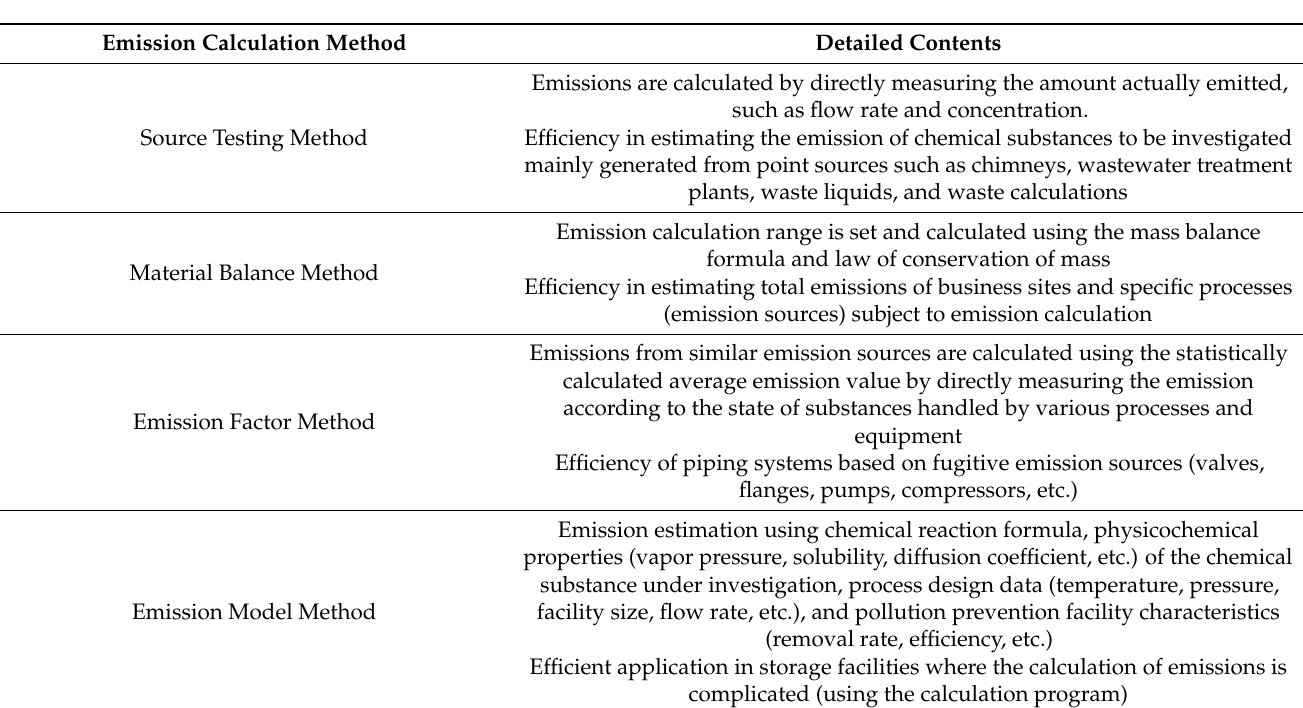
Table 4. Emission calculation method